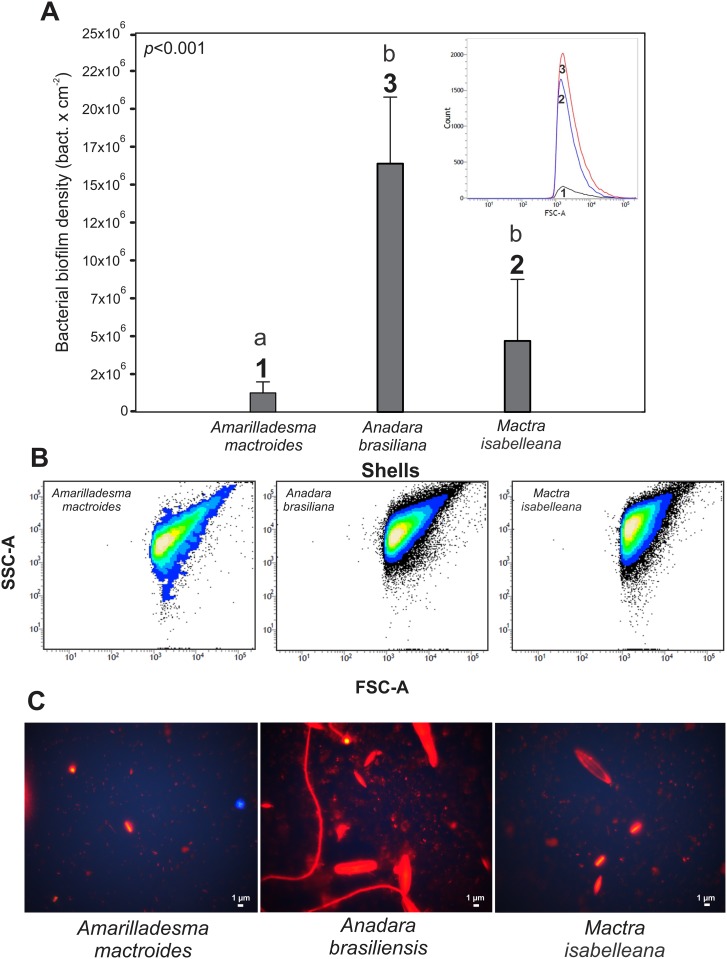
Biofilm community on shells.(A) Bacterial biofilm density (bact cm-2) on different shells. (B) The relative size (FSC-A) and complexity (SSC-A) of the bacterial cells measured by a flow cytometer. Each point represents a bacterial cell. The lighter colors (central part) are related to higher density cells with a determined feature (size × complexity) being characterized as one population. (C) Microorganism communities stained with acridine orange under epifluorescence microscopy (1000X). The vertical lines denote the 95% confidence intervals (standard error*1.96), and the lowercase letters indicate similarities (the same letters) or significant differences (different letters) between the shells (Tukey test).